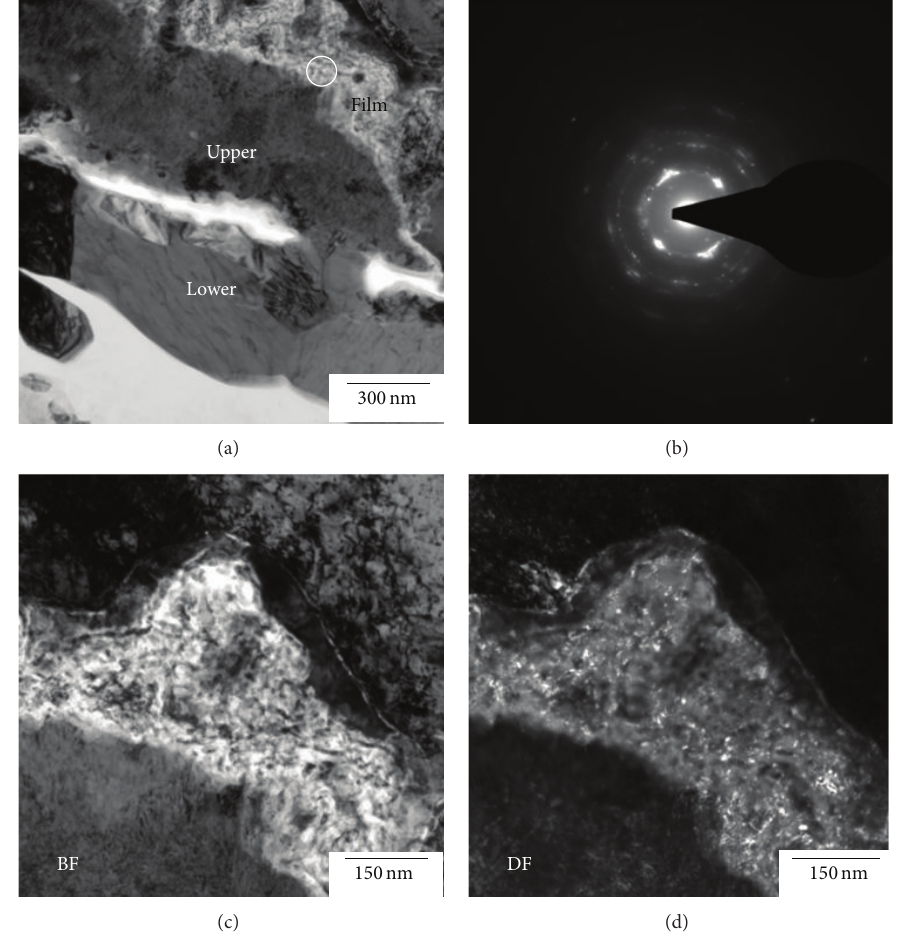
Figure 7: Small upper polycrystal IMC